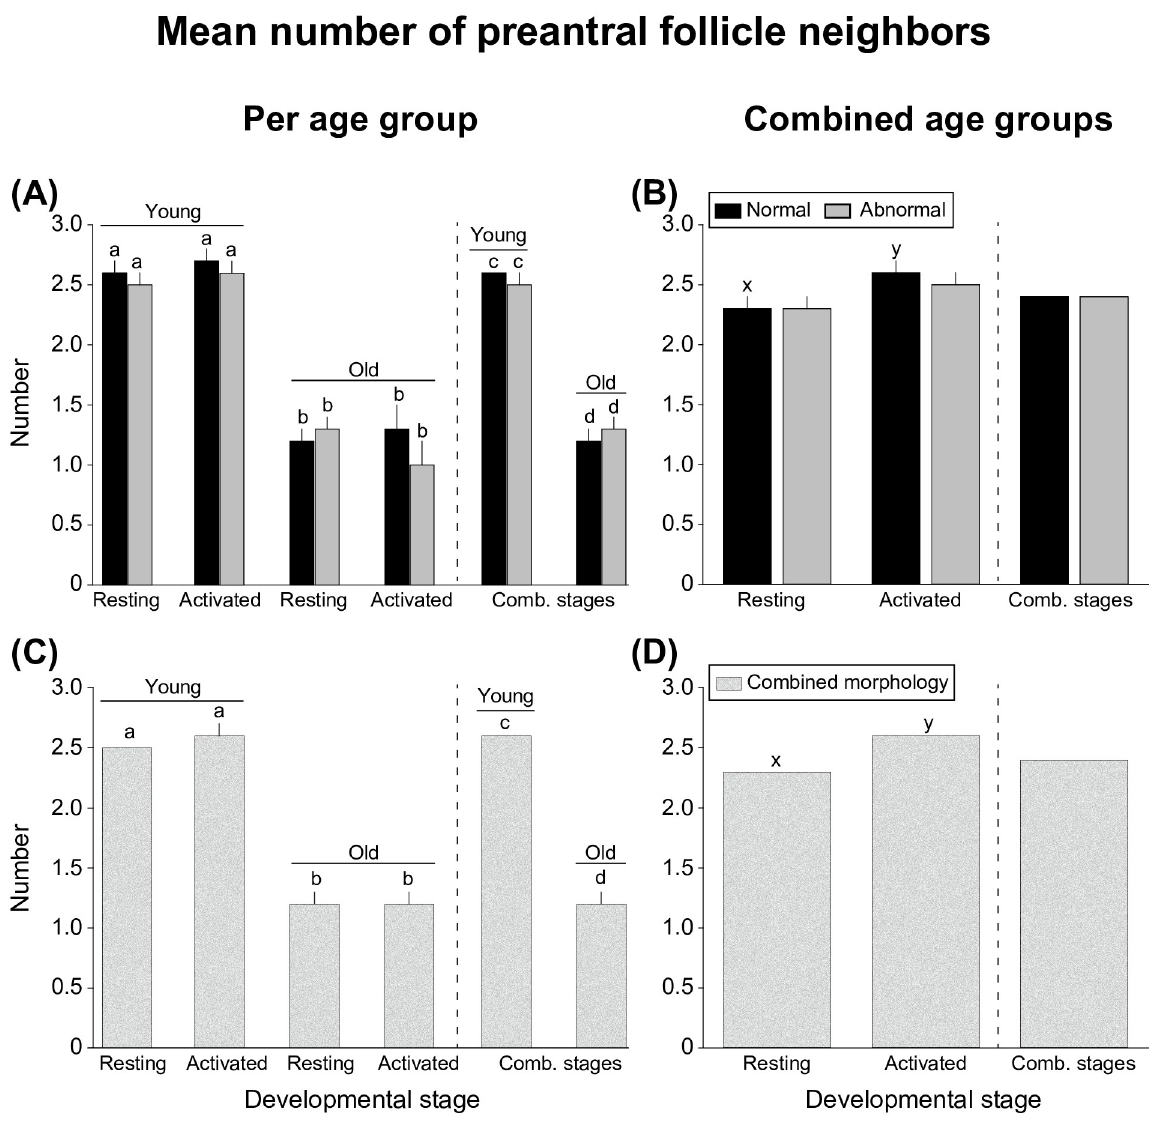
Fig 5. Mean number ( ± SEM) of neighbors per preantral follicle according to developmental stage for (A, B) morphology and for (C, D) combined morphologies (A, C) per age group and (B, D) when ages were combined. a,b Within the same developmental stage and morphology, values without a common superscript differed. c,d Within the same morphology when developmental stages were combined, values without a common superscript differed. x,y Between developmental stages and when ages were combined, values without a common superscript differed. No differences ( P > 0.05) were observed when ages were combined comparing abnormal resting and activated follicles or between morphologies when developmental stages were combined. All data were analyzed using the Kruskal-Wallis test followed by Dunn’s test. Comb.,